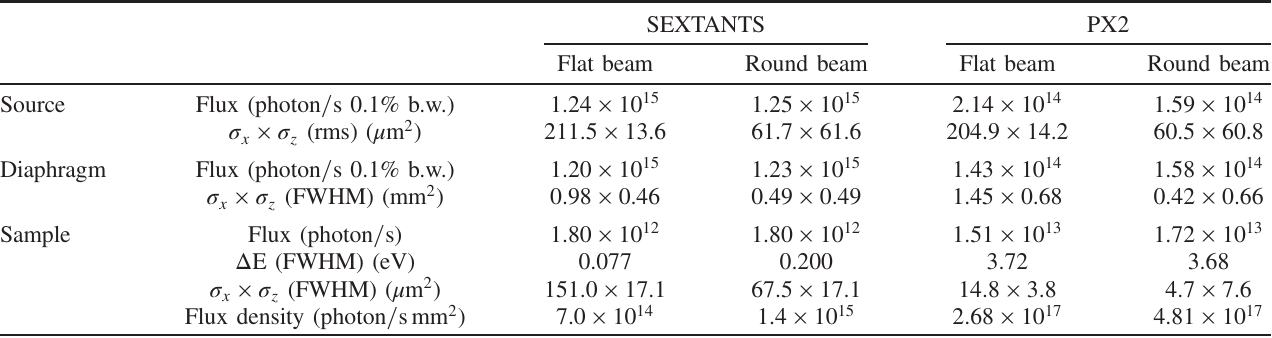
TABLE II. Photon flux and photon beam sizes at source, diaphragm and sample for the SEXTANTS and PX2 beam lines. Photon energies are respectively 780 eV and 12.7